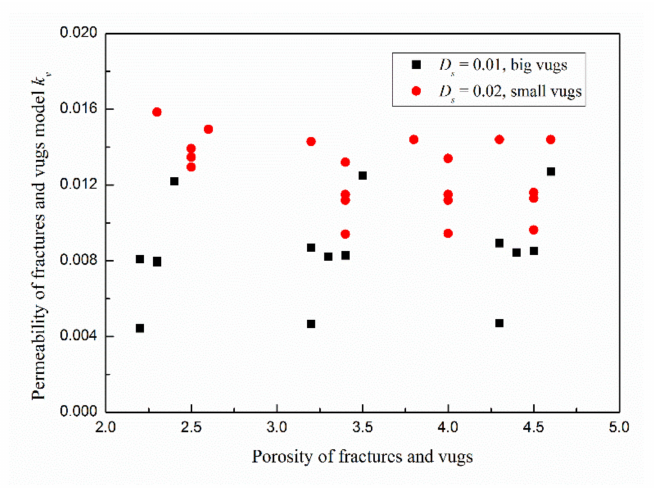
Figure 12. Comparison between big vugs and small vugs with different fracture